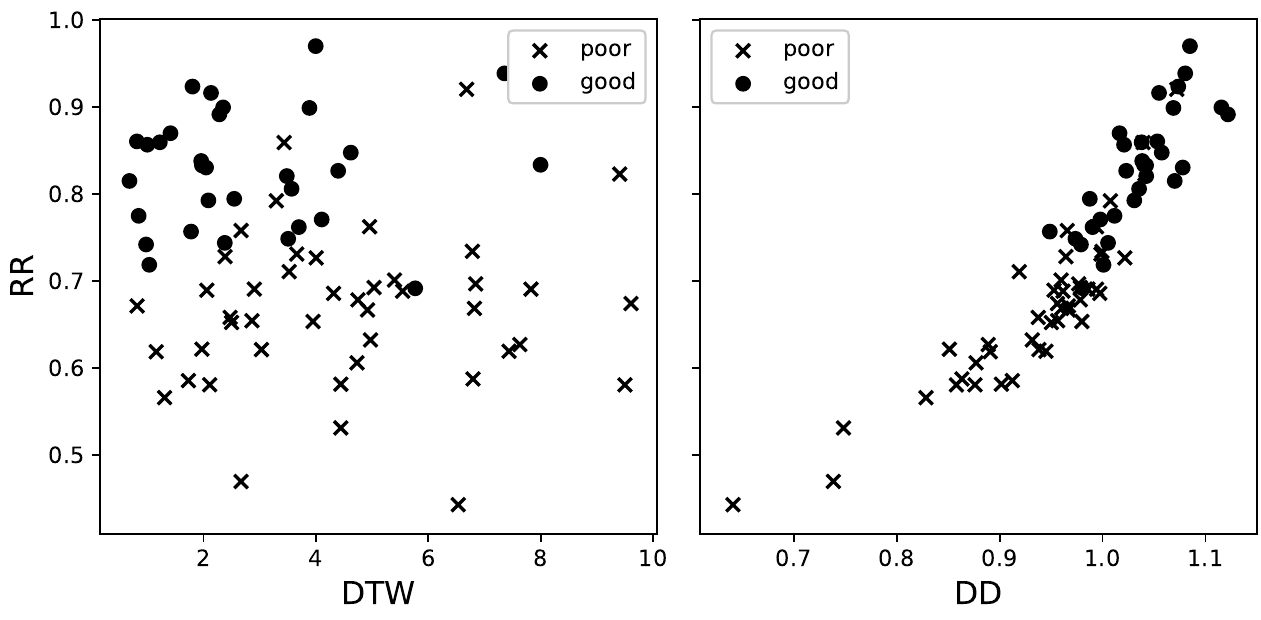
Figure 10. Single task attempts in feature space: DTW + RR ( left ), DD + RR ( right ).